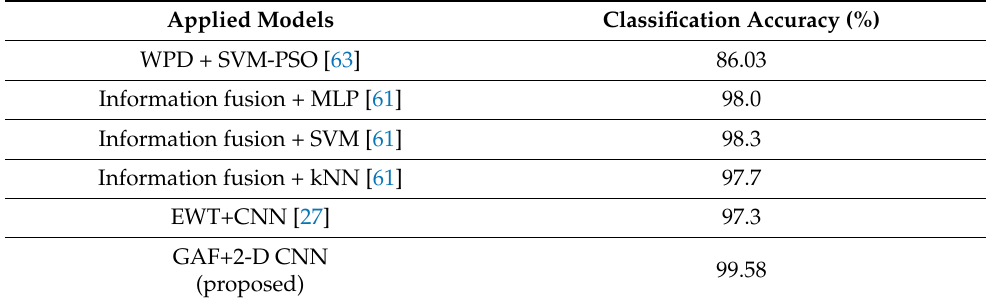
Table 8. The classification results of some existing works.